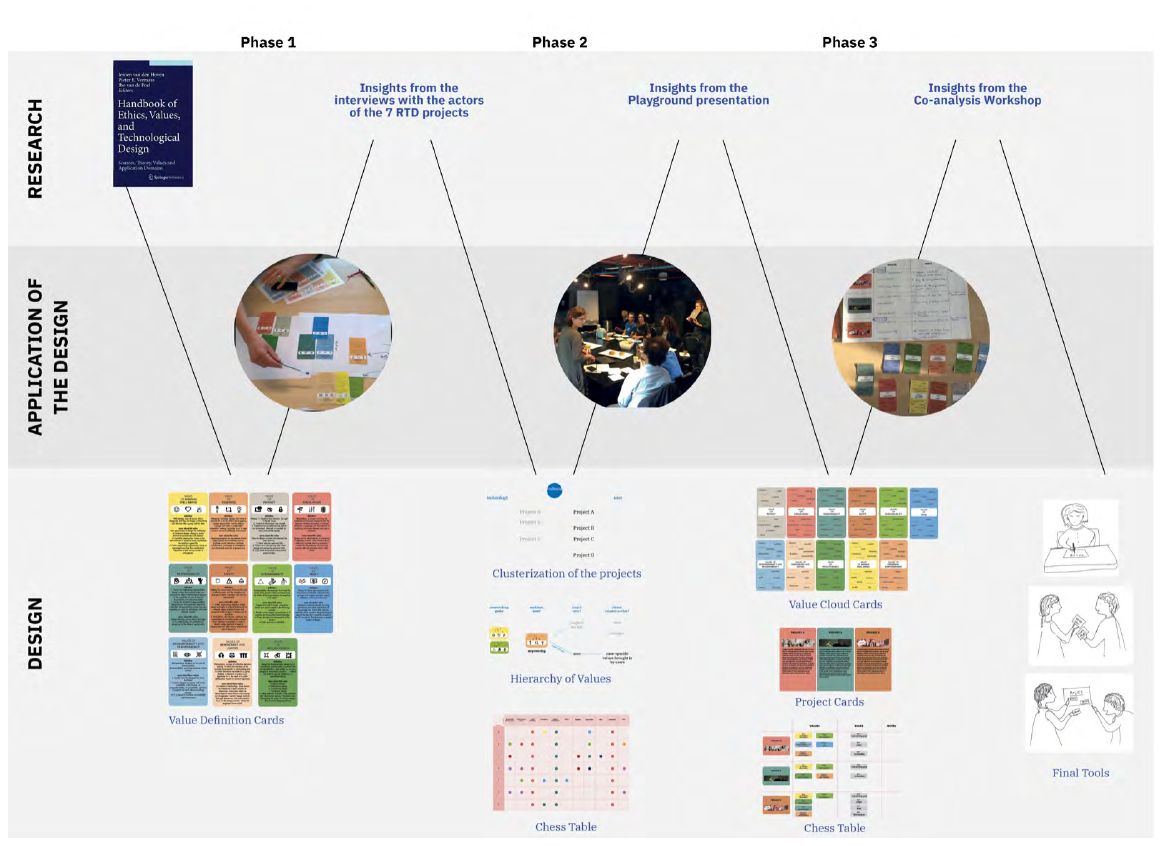
Process overview for Research through Design for accounting Values in design. ©Conversano et al.,